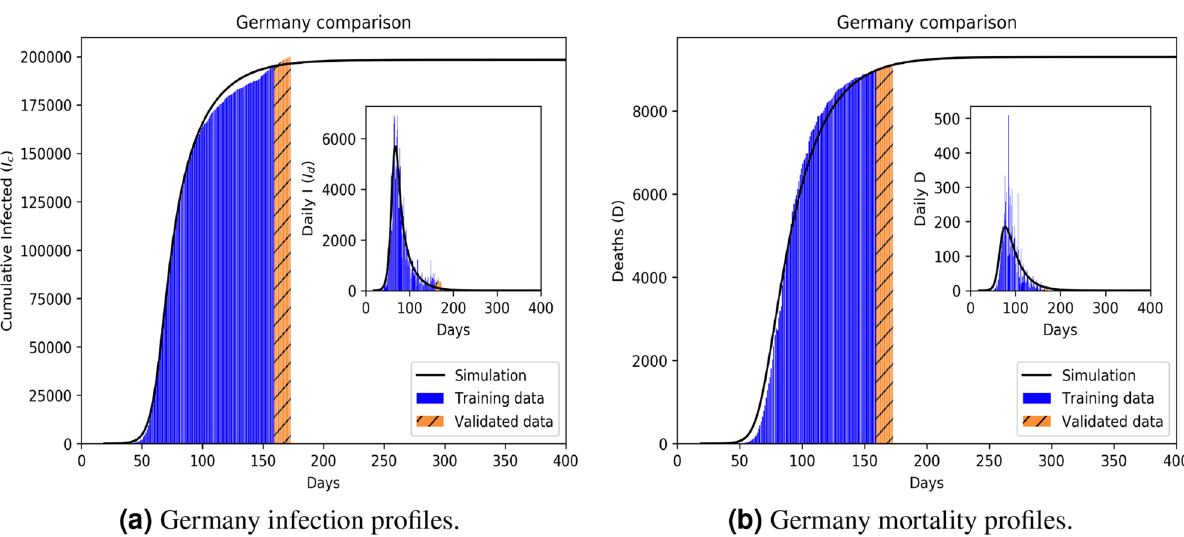
Figure 3. Infection ( a ) and mortality ( b ) epidemiology for Germany (Class B). Outsets represent cumulative statistics while the insets are for daily updates in the number of infected and death respectively. Here “0”